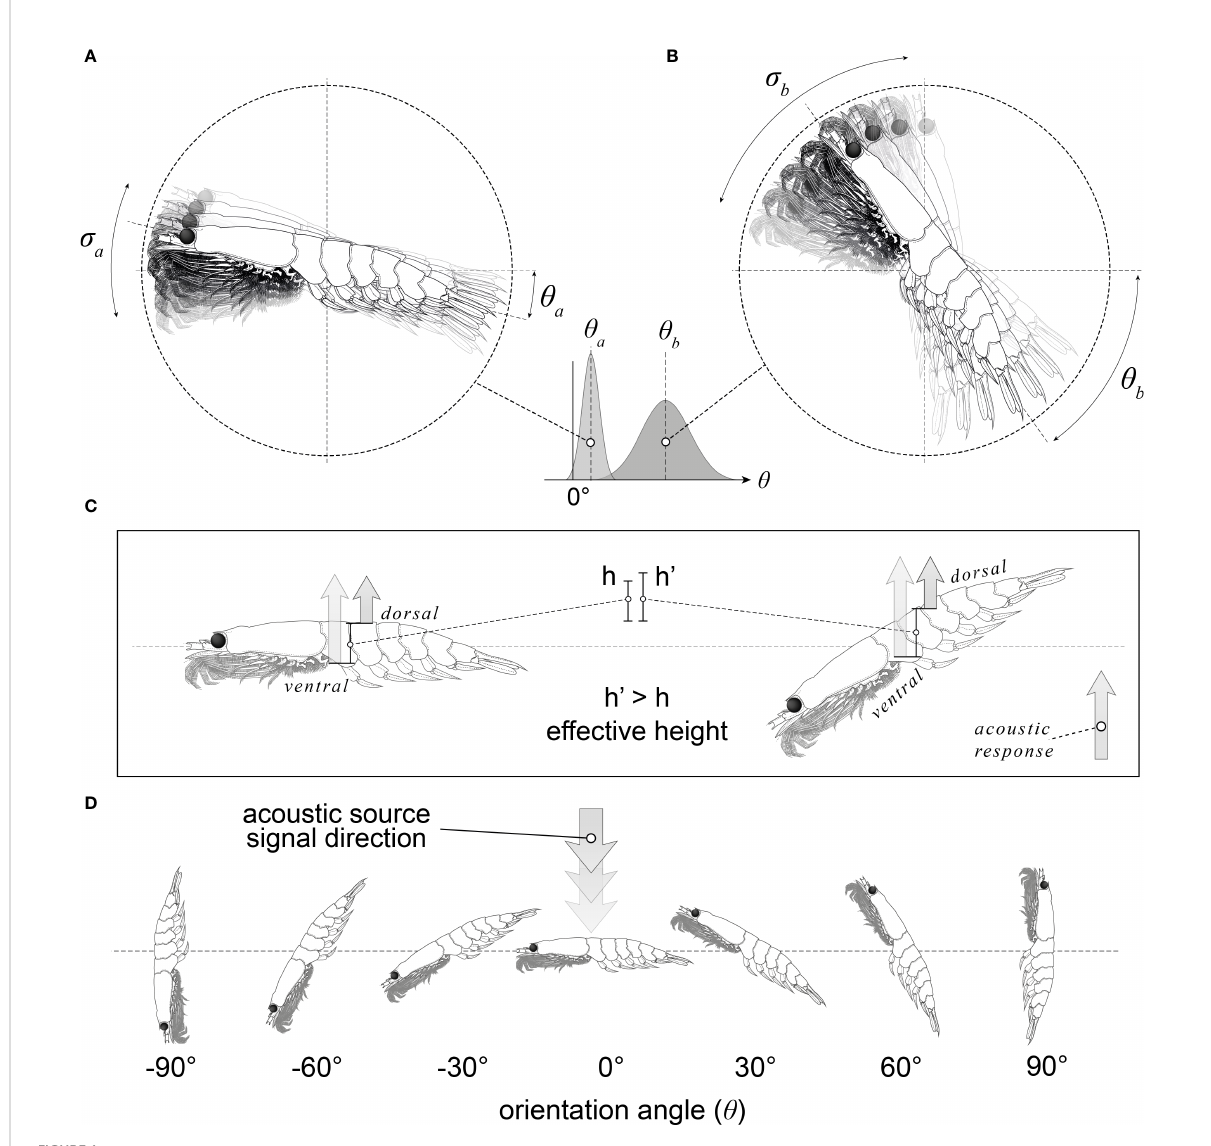
FIGURE 1 An illustration of krill orientation with respect to the incident acoustic beam. Panels (A, B) illustrate the range of krill orientations present within a swarm of krill; a: low mean orientation ( ϴ a ) and small standard deviation ( a a ), b: high mean orientation ( ϴ b ) and large standard deviation ( s a ). A krill orientation distribution is approximated as a Gaussian distribution with a mean orientation angle and a standard deviation. Panel (C) depicts how the orientation of the krill changes the effective height (the distance between the dorsal and ventral surfaces in the direction of the incident acoustic wave). Panel (D) depicts a range of krill orientations where to orientation angle is the angle between the incident acoustic beam and a normal to the midline of the